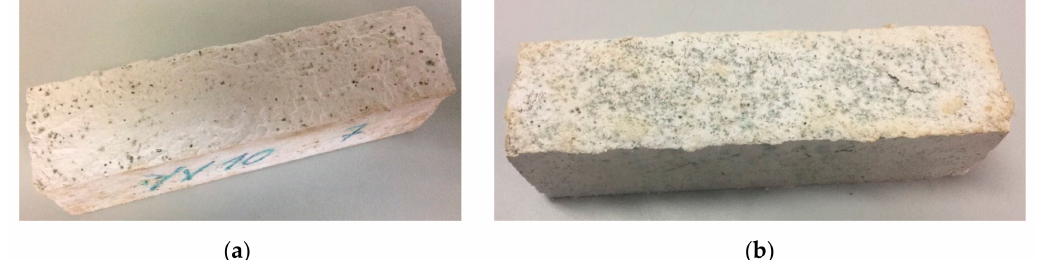
Figure 6. Small spots of mildew in wood shavings plasters after 15 wetting–drying cycles. ( a ) WS10; ( b ) WS20.